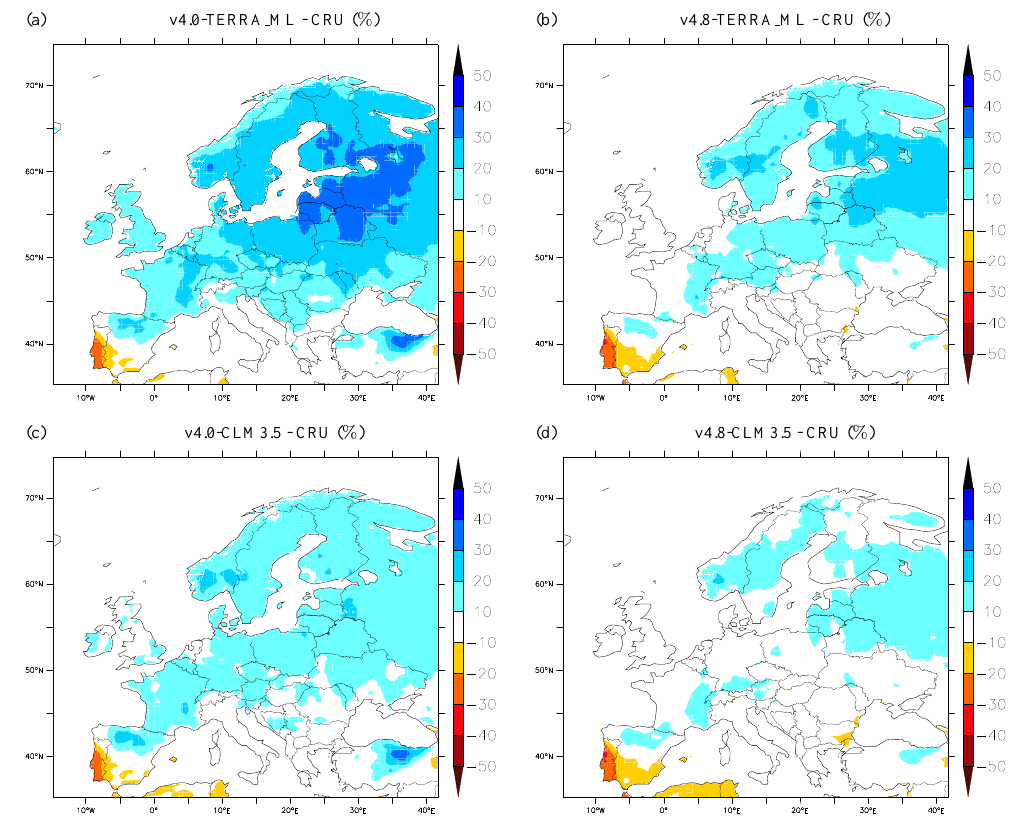
Fig. 2. Summer (JJA) mean cloud cover bias (model minus CRU) for the different experiments. The considered time period is 1986-1995. Table 2. Squared correlation ( R 2 ) between modeled and observed (E-OBS) 2-meter temperature. Time se- ries are domain-averaged over eight different regions as defined in Figure 4. Correlations are based either on monthly or daily means in both cases considering only data between June and August.